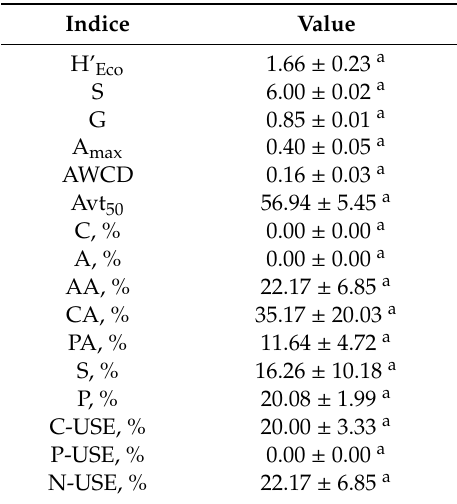
Table 4. Biolog EcoPlate indices of the KPL